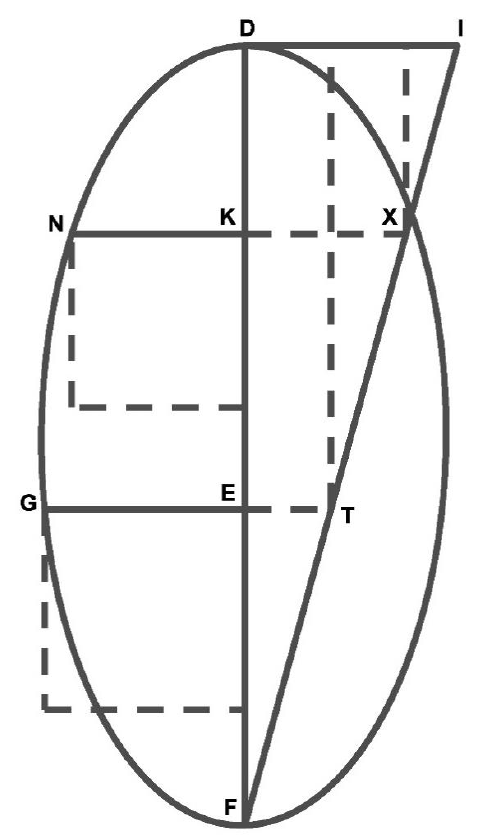
Figure 5. Ellipse of vertex 𝐷 and transverse diameter 𝐹𝐷 as defined in prop. 1.13 in the text.